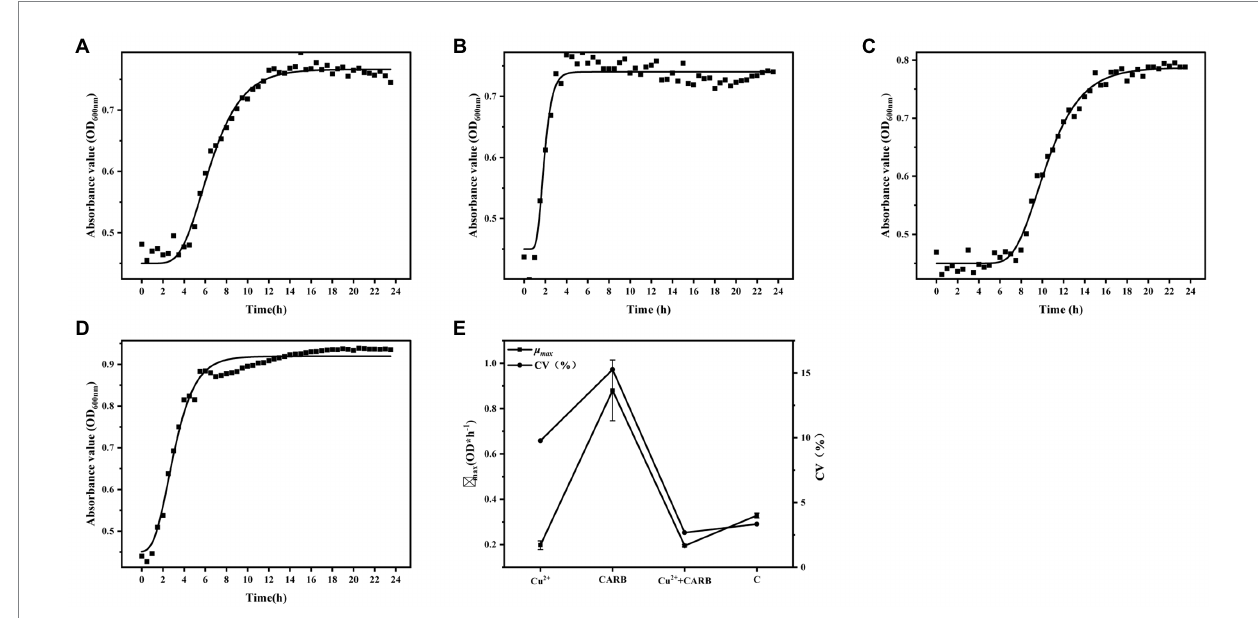
FIGURE 1 Determination of growth curve of Vibrio parahaemolyticus under different treatment conditions. (A) 1/2 MIC Cu 2+ treatment, (B) 1/2 MIC CARB treatment, (C) 1/2 MIC Cu 2+ +CARB treatment, (D) control, (E) mean value curve and coefficient of variation curve (CV) of μ max